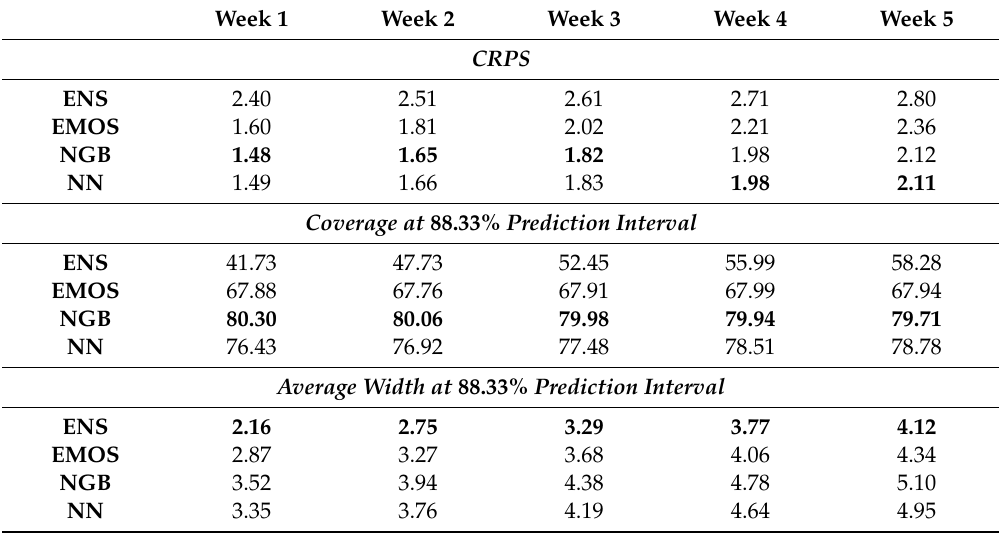
Table 2. Comparison of probabilistic forecasts of the 2-m maximum air temperature over East Asia for the whole year of 2016 at different lead times. The values representing the best performance are marked in bold. CRPS, continuous ranked probability score; ENS, raw ensemble; EMOS, ensemble model output statistics; NGB, natural gradient boosting; NN, neural network; MAE, mean absolute error; RMSE, root-mean-square-error.